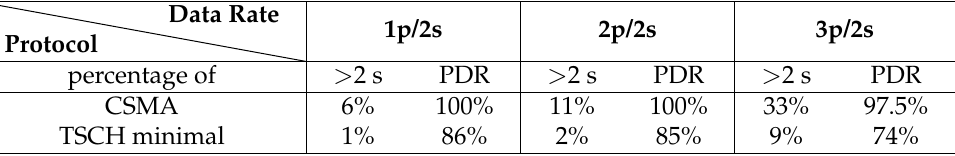
Figure 5. Packet Delay—CSMA. Table 2. Percentages of packet delays exceeding 2 s for each scenario along with their respective PDR